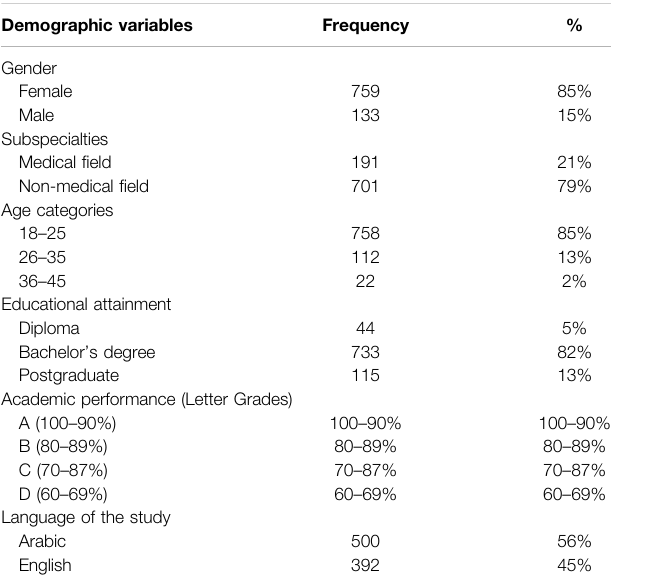
TABLE 1 | Participant characteristics.